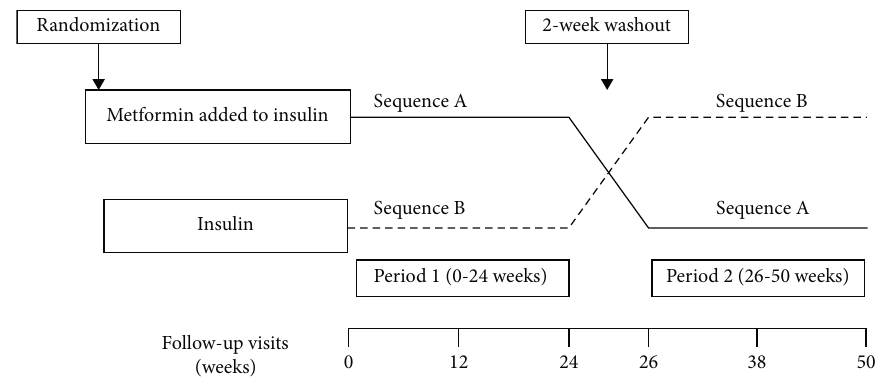
Figure 1: Eligible participants were randomized 1:1 to receive metformin (started at a dose of 500mg daily for 1 week, with a subsequent dose escalation to 500 mg twice daily) added to insulin for 24 weeks followed by insulin treatment alone for a subsequent 24 weeks (sequence A) or vice versa (sequence B), separated by a 2-week washout period. The face-to-face followed-up visits were at weeks 0, 12, 24, 26, 38, and